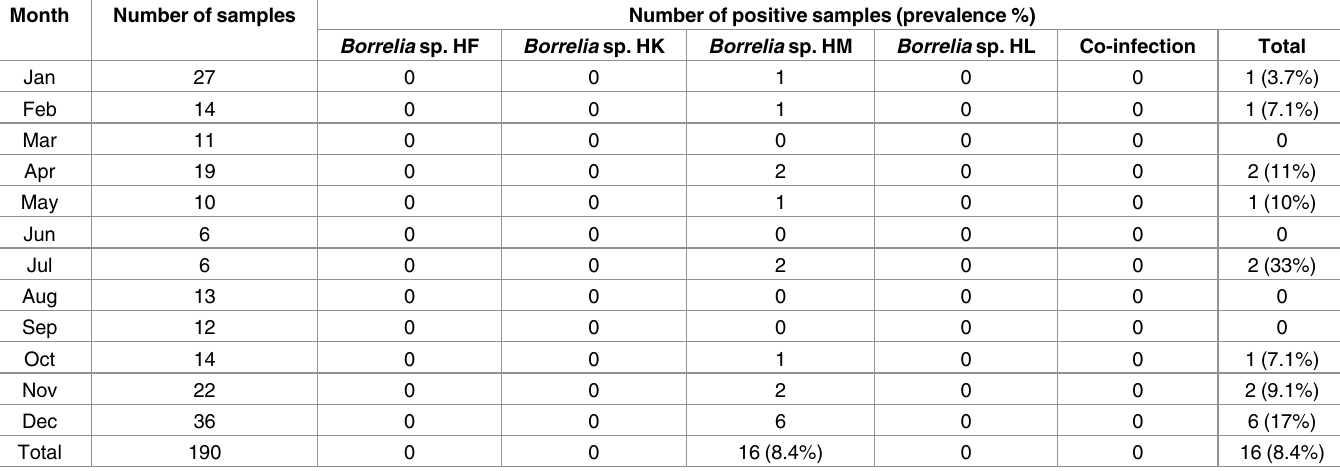
Table 4. Prevalence of Borrelia sp. in wild boars collected from Shimonoseki, Yamaguchi Prefecture.